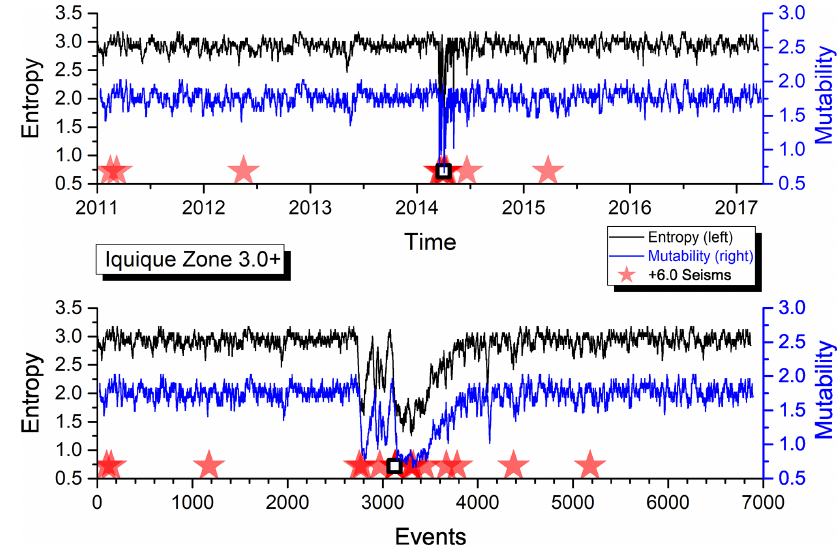
Figure 3. Shannon entropy and mutability as functions of time for the seismic activity of zone A. The open star marks the position of the earthquake identified in Table 1. The abscissa in the upper panel corresponds to real time t i , while in the lower panel it represents the natural time of successive events (filtered seisms) denoted by the order label i (Figs. 4–6 use the same procedure).